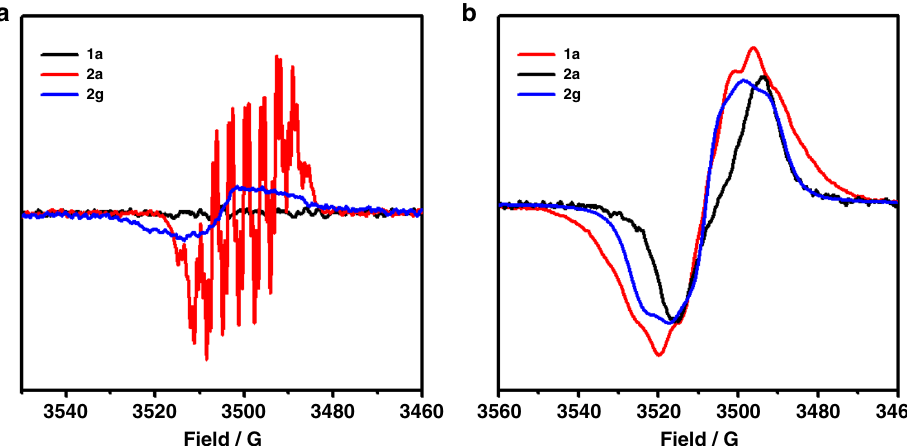
Fig. 7 Electron paramagnetic resonance (EPR) spectra. a After electrolysis in MeCN/MeOH (7.0 mL/3.0 mL) for 15 min. b After electrolysis in MeCN/HFIP (5.0 mL/5.0 mL) for 15 min